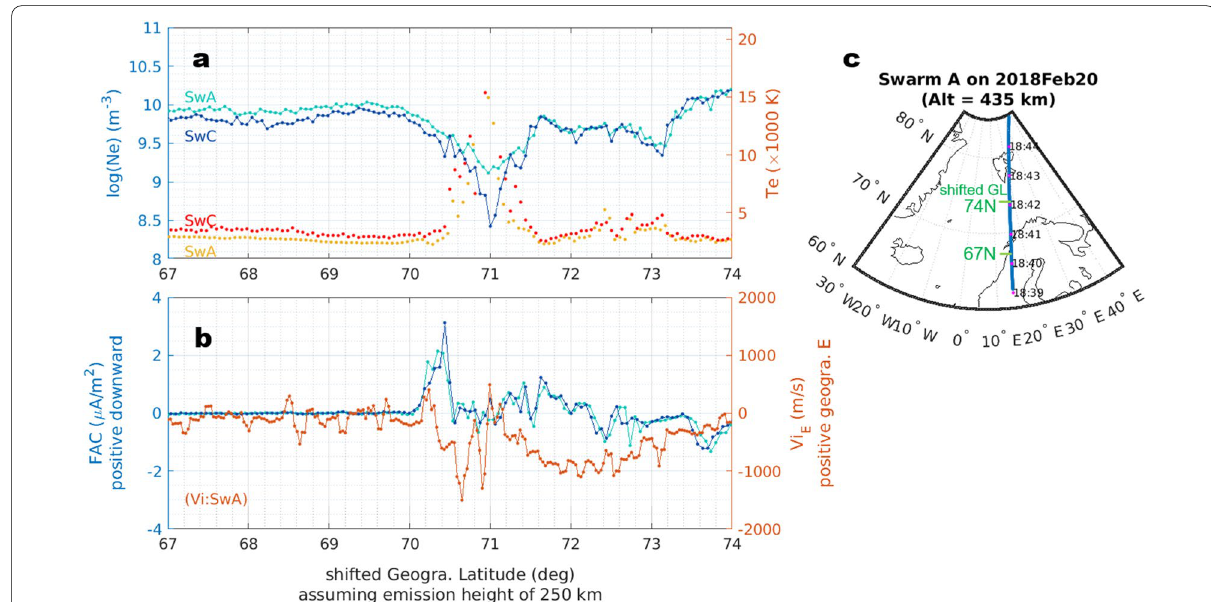
Fig. 4 a Electron density and temperature (cold and warm hues, respectively) measured with the Swarm A (lighter color) and Swarm C (darker color) satellites. b FAC and eastward ion velocity (cold and warm hues, respectively; positive downward and eastward, respectively) measured with the Swarm A (lighter color) and C (darker color) satellites. The latitude at the Swarm measurement is shifted by 0.39–0.28° (dependent on latitudes at 67–74°N) poleward while being mapped down along the magnetic field line from the operation altitude of 435 km to the assumed 630‑nm emission height of 250 km. c Swarm A trajectory on the map with time stamp. Locations of the shifted geographical latitudes of 67°and 74°are marked as